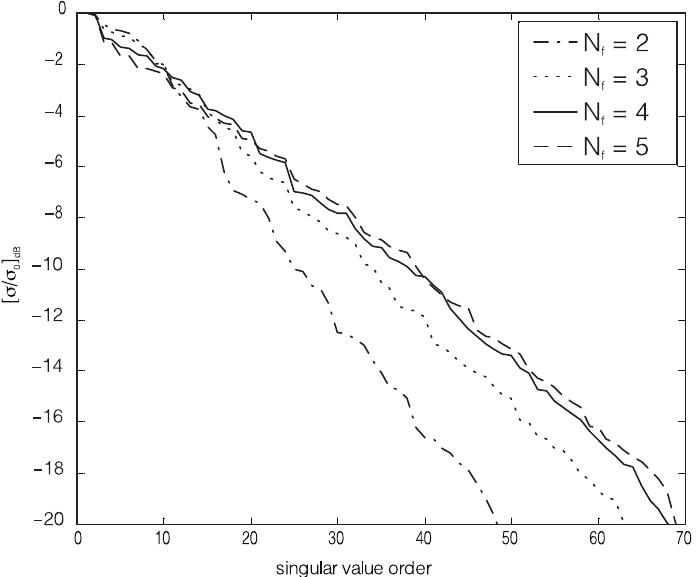
Fig. 3. Behavior of the singular values of L = 2 (100, 300), dashed-dotted line; N band: N f = 5 (100, 150, 200, 250, 300), dashed line; N f